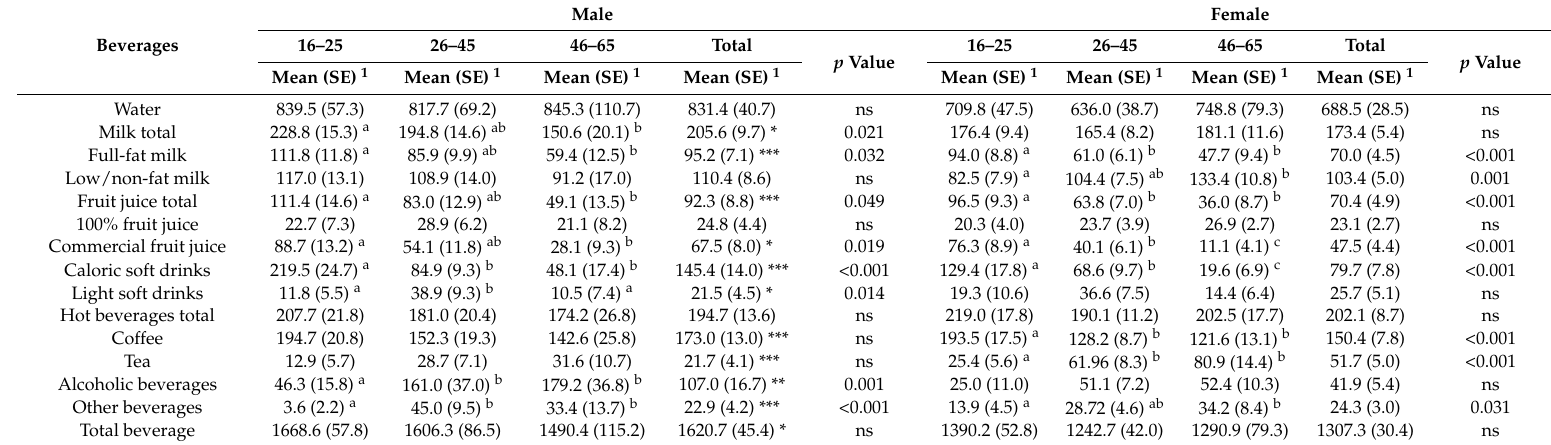
Table 2. Mean daily beverage consumption (g/day) by gender and age group.